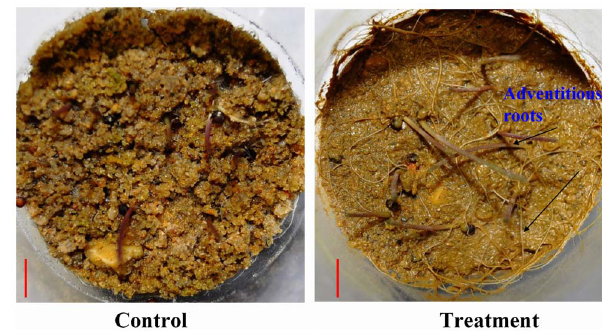
Figure 2. The effect of waterlogging on seedlings of 9981 at the seedling establishment stage. Yellow bars=1.0 cm.